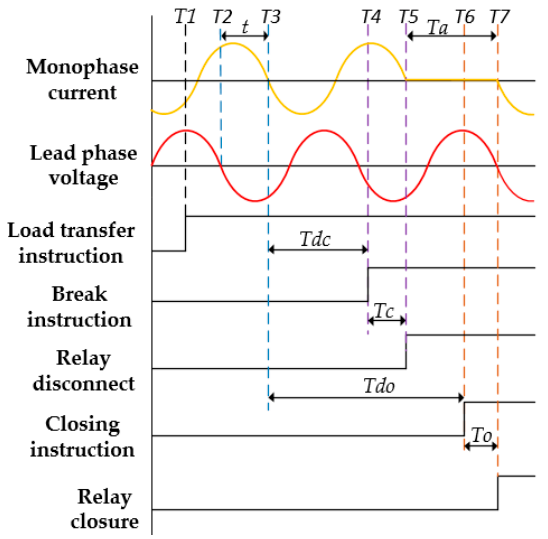
Figure 5. Sequence diagram of switch to the leading phase.